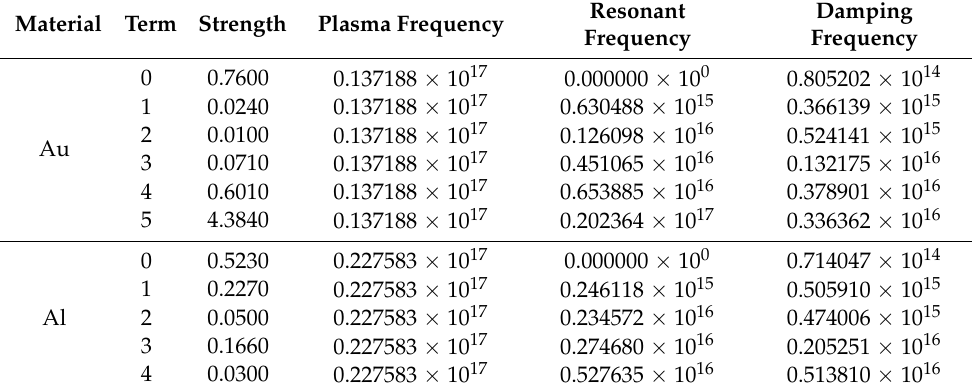
Table 1. Plasmonic parameters which are used for the metallic materials. Material Term